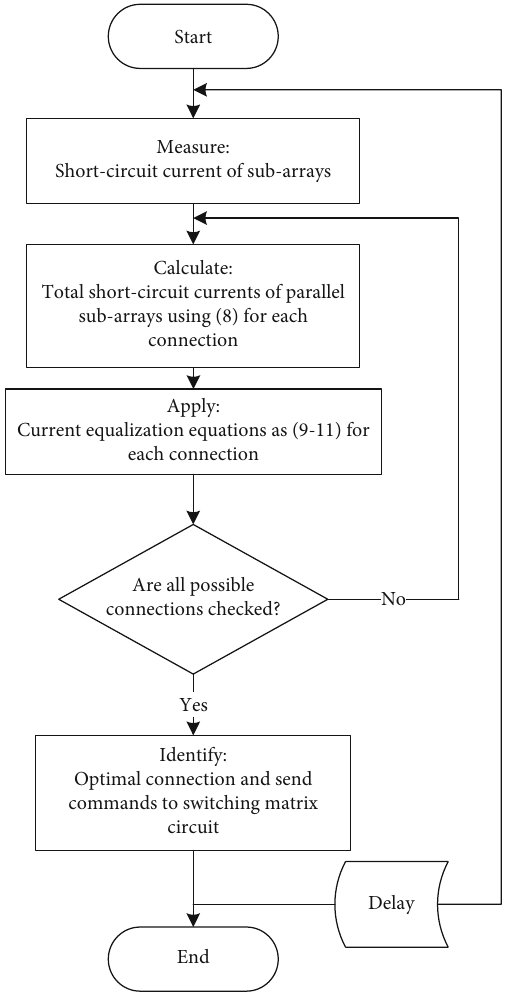
Figure 8: Flow chart of the introduced algorithm.